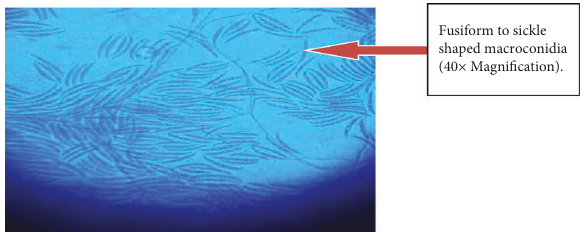
Figure 4: Fusiform to sickle shaped macroconidia of Fusarium species in LPCB stain.